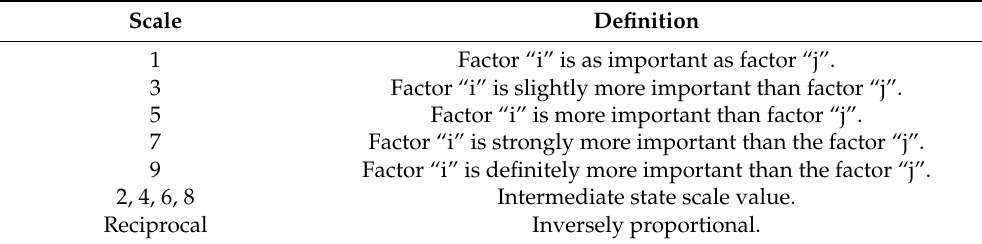
Table 1. Scoring criteria of nine-scale